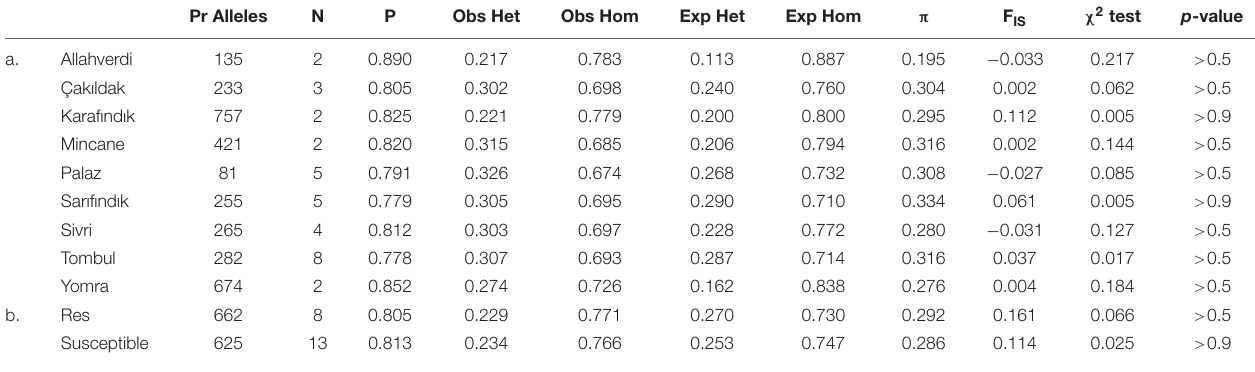
TABLE 2 | Summary of population genetic statistics summarized across all loci for each subpopulation: Number of private (Pr) alleles, number of individuals (N), the mean frequency of the most frequent allele at each locus (P), the observed (Obs) and the expected (Exp) homozygosity (Hom) and heterozygosity (Het), the mean value of estimated nucleotide diversity ( π ), and the mean inbreeding coefficient (F IS ) across all loci, χ 2 test statistic and corresponding p -values of hazelnut varieties (a) and resistant-susceptible accessions (b). Pr Alleles N